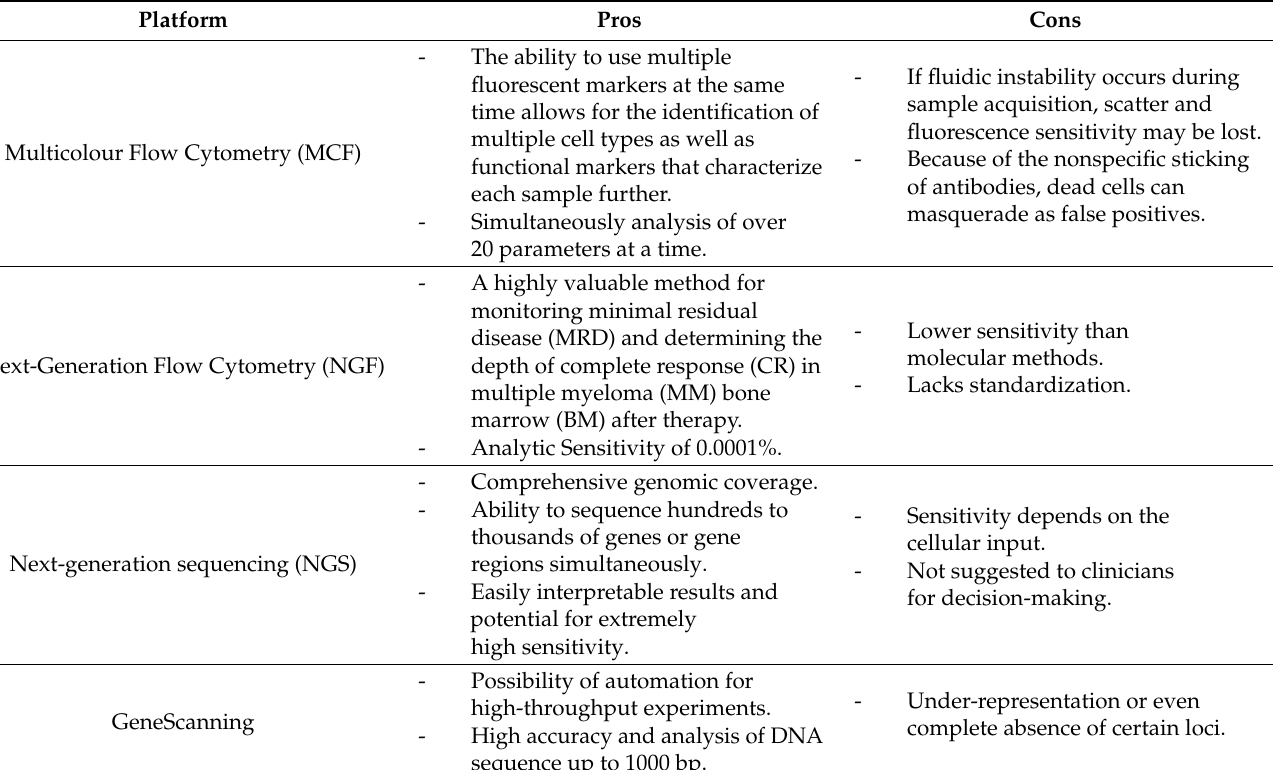
Table 1. Current available and relative pros and cons, platforms to detect CTCs and cfDNA in peripheral blood of patients affected by multiple